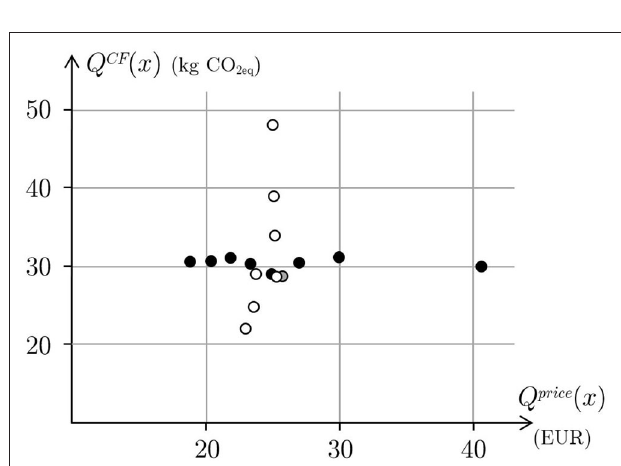
FIGURE 3 | The black circles represent the price and the carbon footprint of several optimal menus obtained for different targets of price while removing price and carbon footprint from the objective function. The white circles represent the price and the carbon footprint of several optimal menus obtained for different targets of carbon footprint while removing price and carbon footprint from the objective function. The gray circle represent the price and the carbon footprint of the average